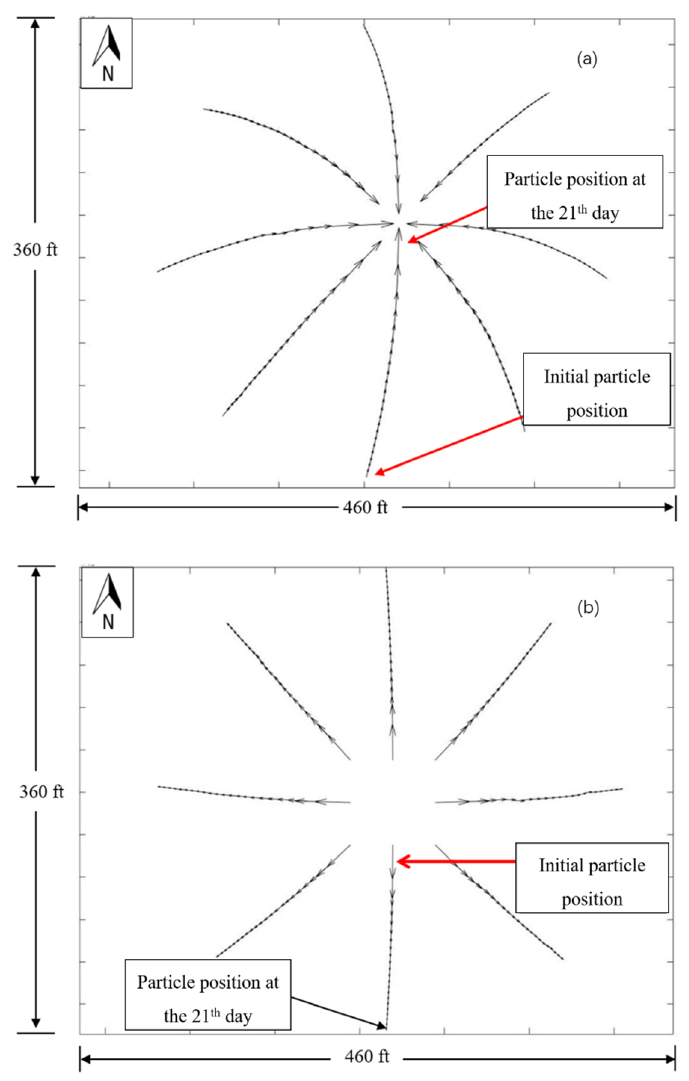
Figure 4. Movement of particles around one representative of eight wells for 21 days under ( a ) pumping and ( b ) injection conditions at the Meadows Pumping Center, CO, USA.